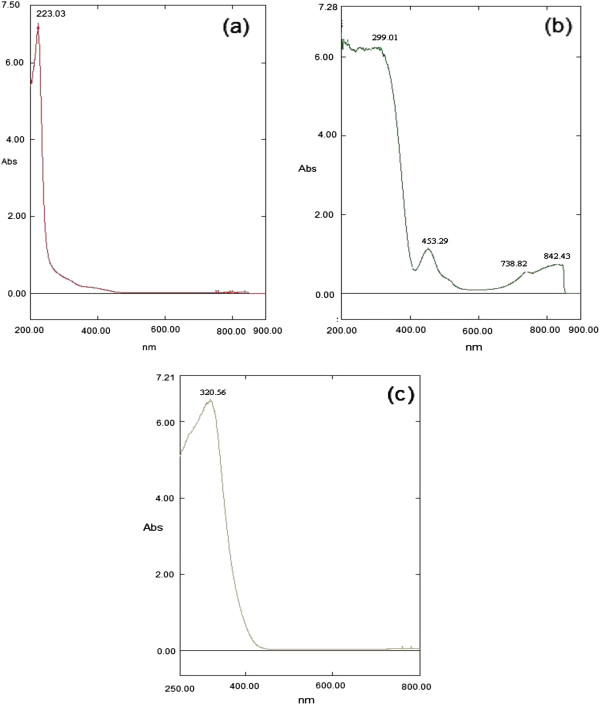
Optical absorbance spectra of the metal tungstates. (a) BaWO4, (b) NiWO4 and (c) Bi2WO6.